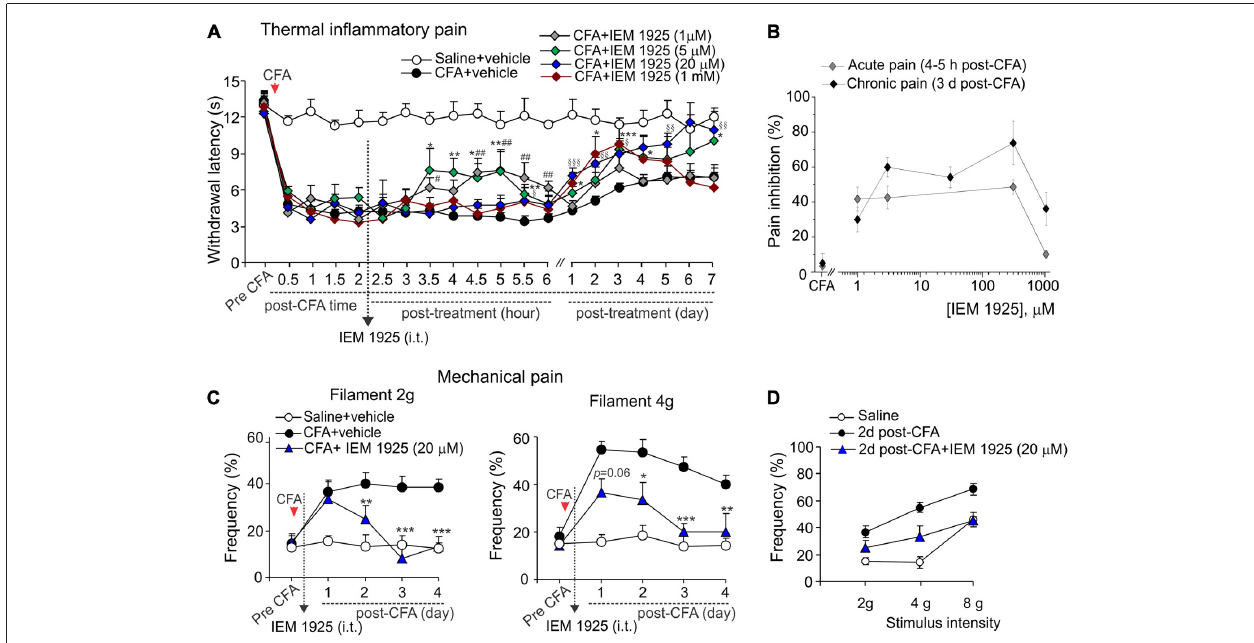
FIGURE 5 | Antinociception produced by dicationic compound IEM-1925 on the inflammatory-induced thermal and mechanical hypersensitivities. (A) The Hargreaves pain behavioral test demonstrates the reduced thermal inflammatory hypersensitivity following treatment with IEM-1925 at different concentrations. Data are expressed as mean ± SEM. ∗ p < 0.05, ∗∗ p < 0.01, ∗∗∗ p < 0.001 for 5 µ M of IEM-1925 vs. the correspondent time-point in the CFA-inflamed group. # p < 0.05, ## p < 0.01 for 1 µ M of IEM-1925 vs. the correspondent time-point in the CFA-inflamed group. § p < 0.05, §§ p < 0.01, §§§ p < 0.001 for 20 µ M of IEM-1925 vs. the correspondent time-point in the CFA-inflamed group. One-way ANOVA and Bonferroni post hoc test. (B) The concentration-inhibition curves of the IEM-1925-mediated inhibition of the thermal inflammatory hypersensitivity for the acute and long-lasting inhibitory effects. (C,D) The von Frey behavioral test demonstrates the alleviated mechanical hypersensitivity by IEM-1925 (20 µ M) in response to the 2 g (left graph) and 4 g (right graph) von Frey filaments (C) and the IEM-1925-mediated relief in the inflammatory-induced tactile allodynia in CFA-inflamed animals on day 2 after treatment (D) . Results are presented as mean ± SEM. ∗ p < 0.05, ∗∗ p < 0.01, ∗∗∗ p < 0.001 for 20 µ M of IEM-1925 vs. the correspondent time-point in the CFA-inflamed group. One-way ANOVA and Bonferroni post hoc